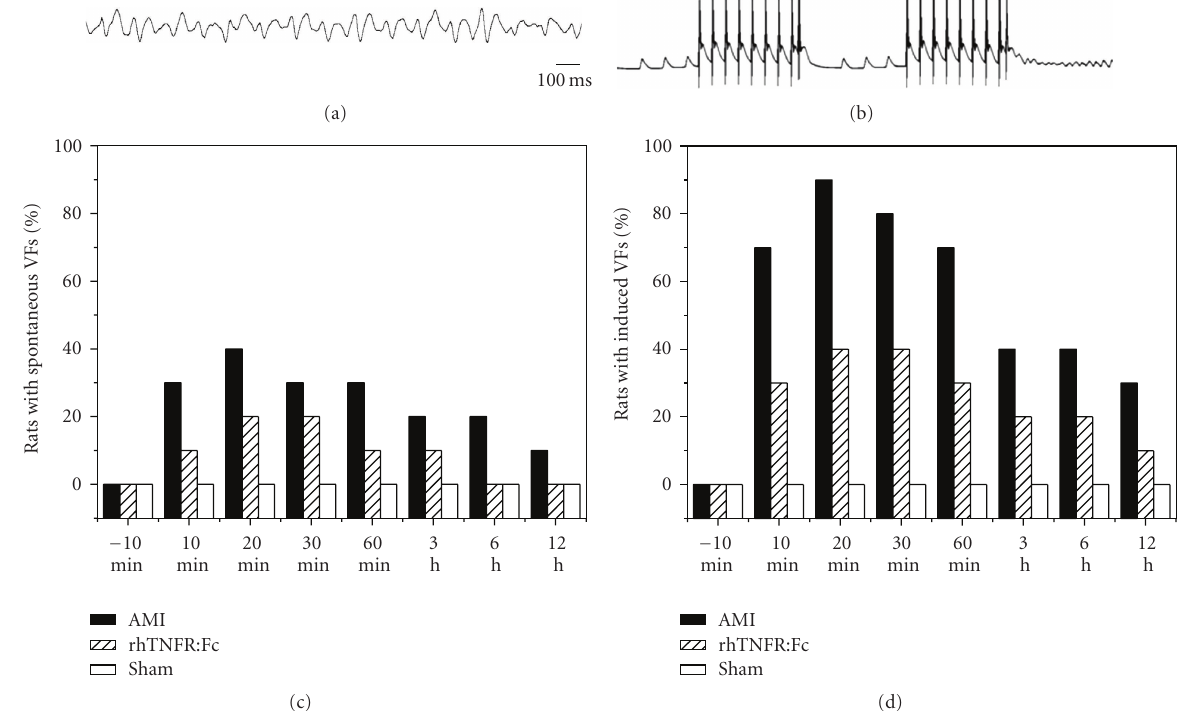
Figure 3: VFs caused by LAD ligation. (a) VF recorded by ECG; (b) VF recorded by MAP electrode. (c) Percentages of rats with spontaneous VFs; (d) percentages of rats with induced VFs.